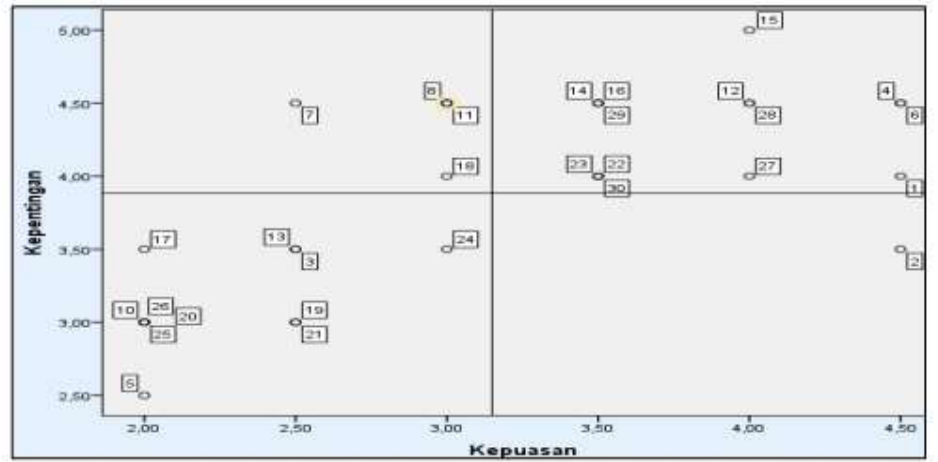
Figure 4. Importance Performance Analysis West Bangka Source: Processed,